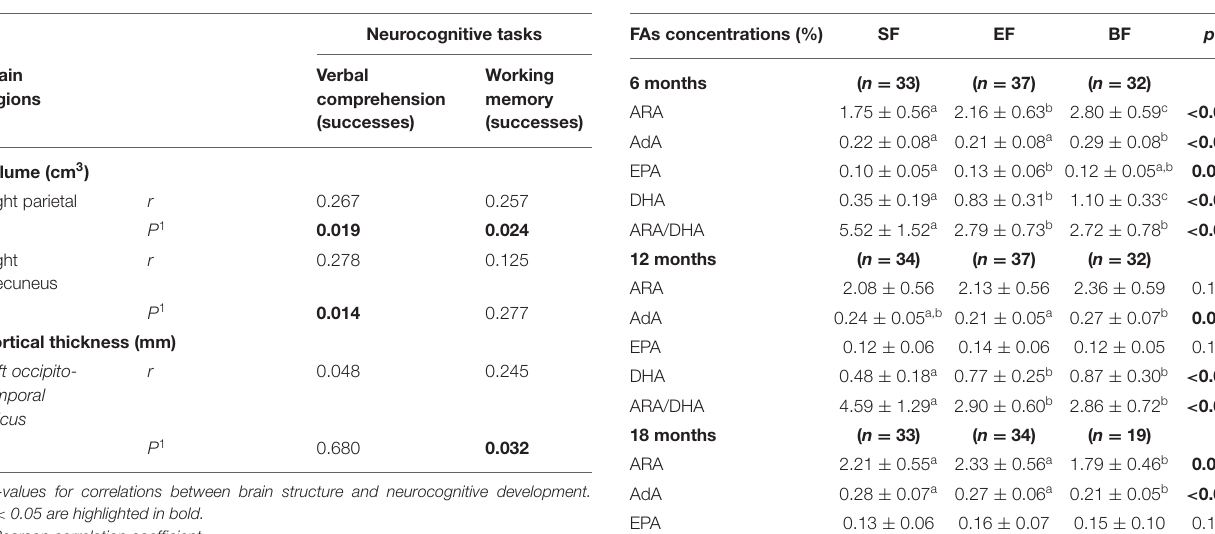
TABLE 5 | Influence of type of early feeding on long-chain polyunsaturated fatty acids (LC-PUFAs) concentration in infants at 6, 12, and 18 months of life 1